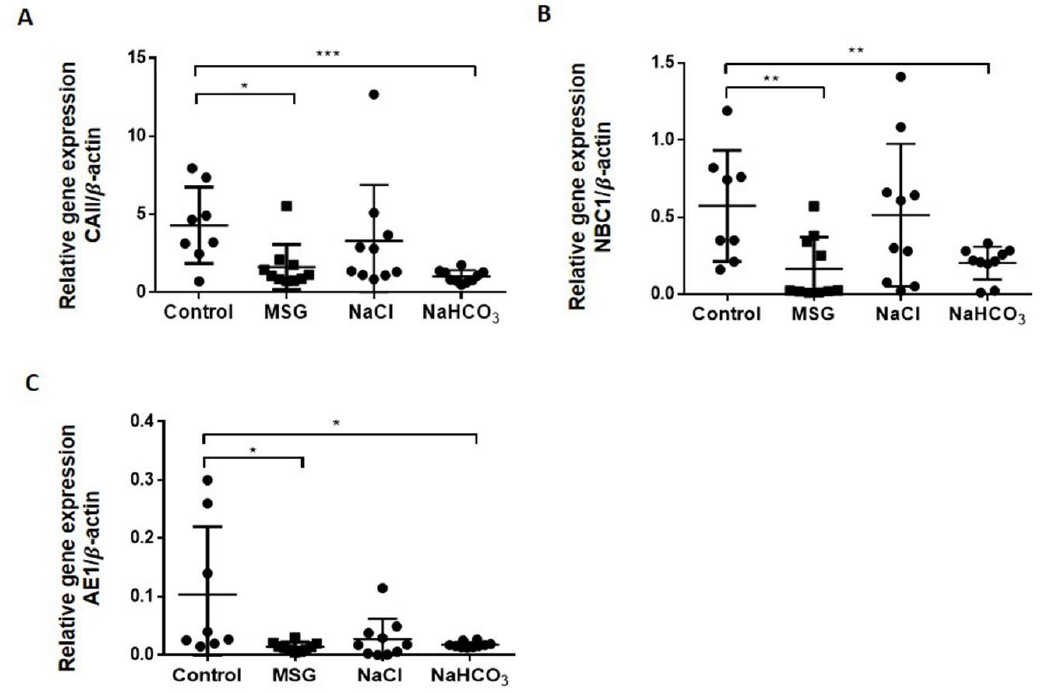
Figure 3. Changes in mRNA expression of ion exchanger genes in cortex layers of rat kidney after 14 days of MSG ( n = 10), NaCl ( n = 10) and NaHCO 3 ( n = 10) supplementation compared to controls ( n = 8) ( A ) CAII , ( B ) NBC1 , ( C ) AE1 . Data are shown as mean ± SEM relative gene expression with beta-